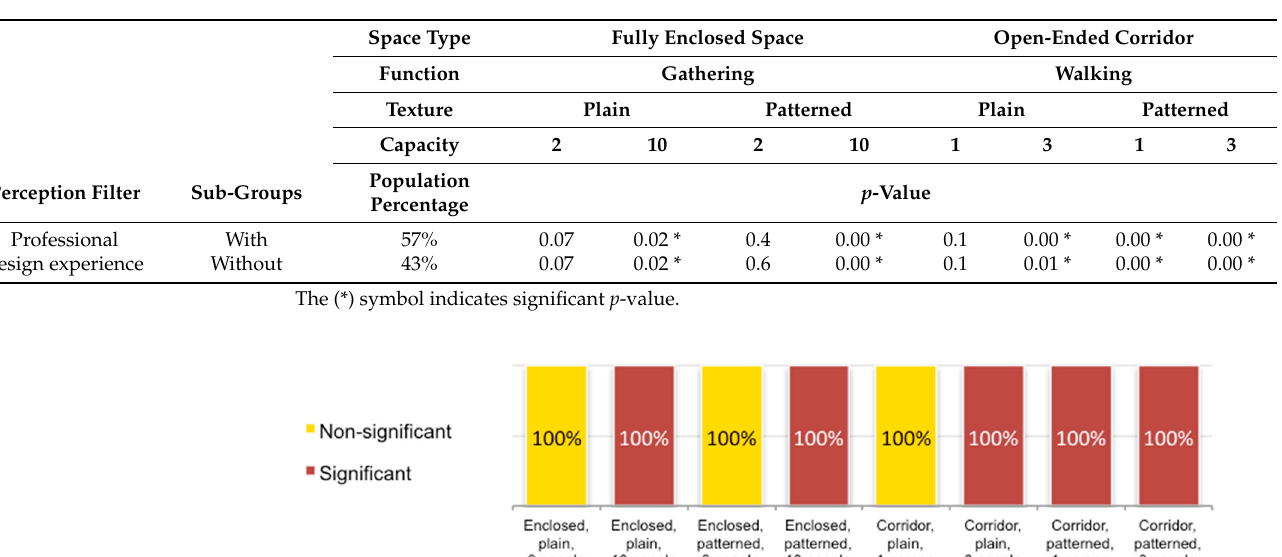
Table 6. Professional design experience perception filter and comparisons of space size variations between IVRIE and DT systems.